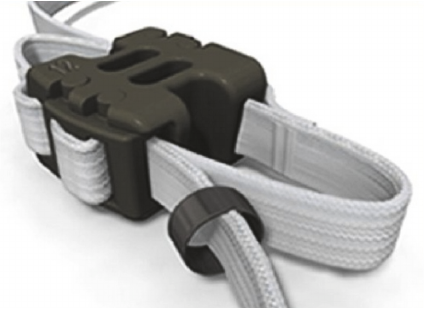
Figure 4: The second-generation Wallis interspinous spacer. DIAM rigid. It is augmented by two woven Dacron ribbons, which are wrapped around the spinous processes and fixed under tension.